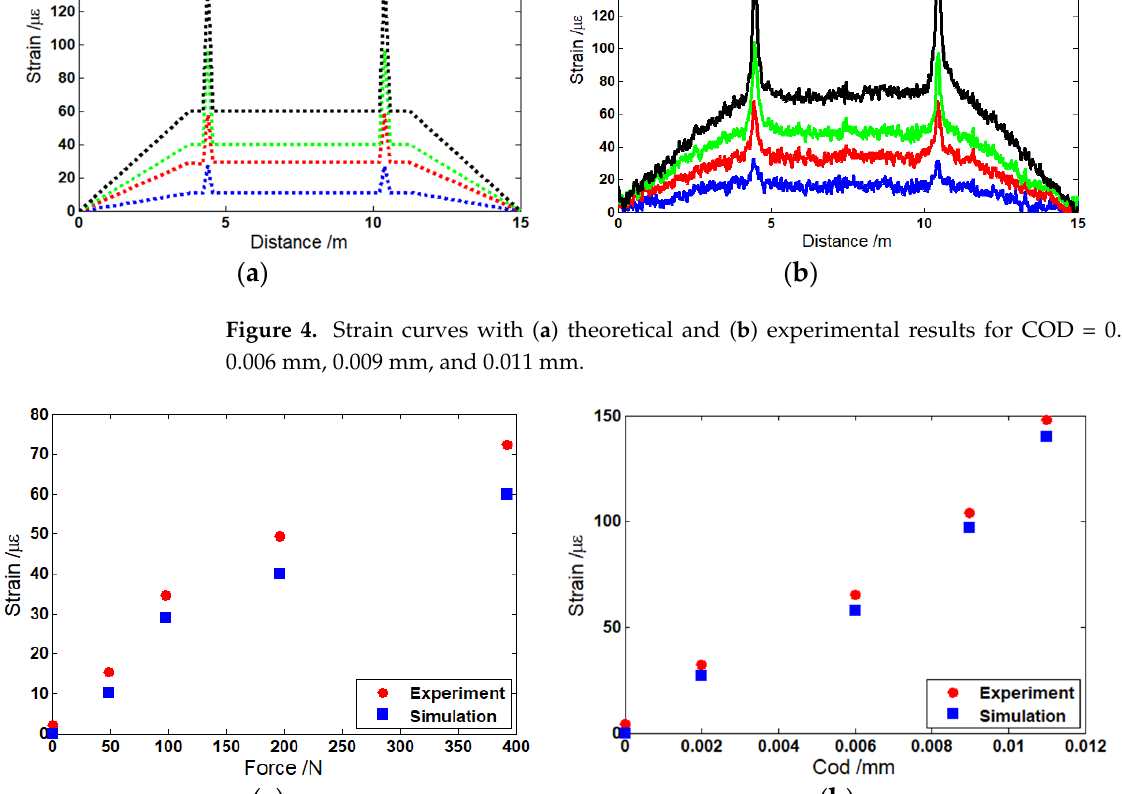
Figure 5. ( a ) Comparison of strain between theoretical and experimental results for F = 49 N, 98 N, 196 N, and 392 N. ( b ) Comparison of strain between theoretical and experimental results for COD = 0.002 mm, 0.006 mm, 0.009 mm, and 0.011